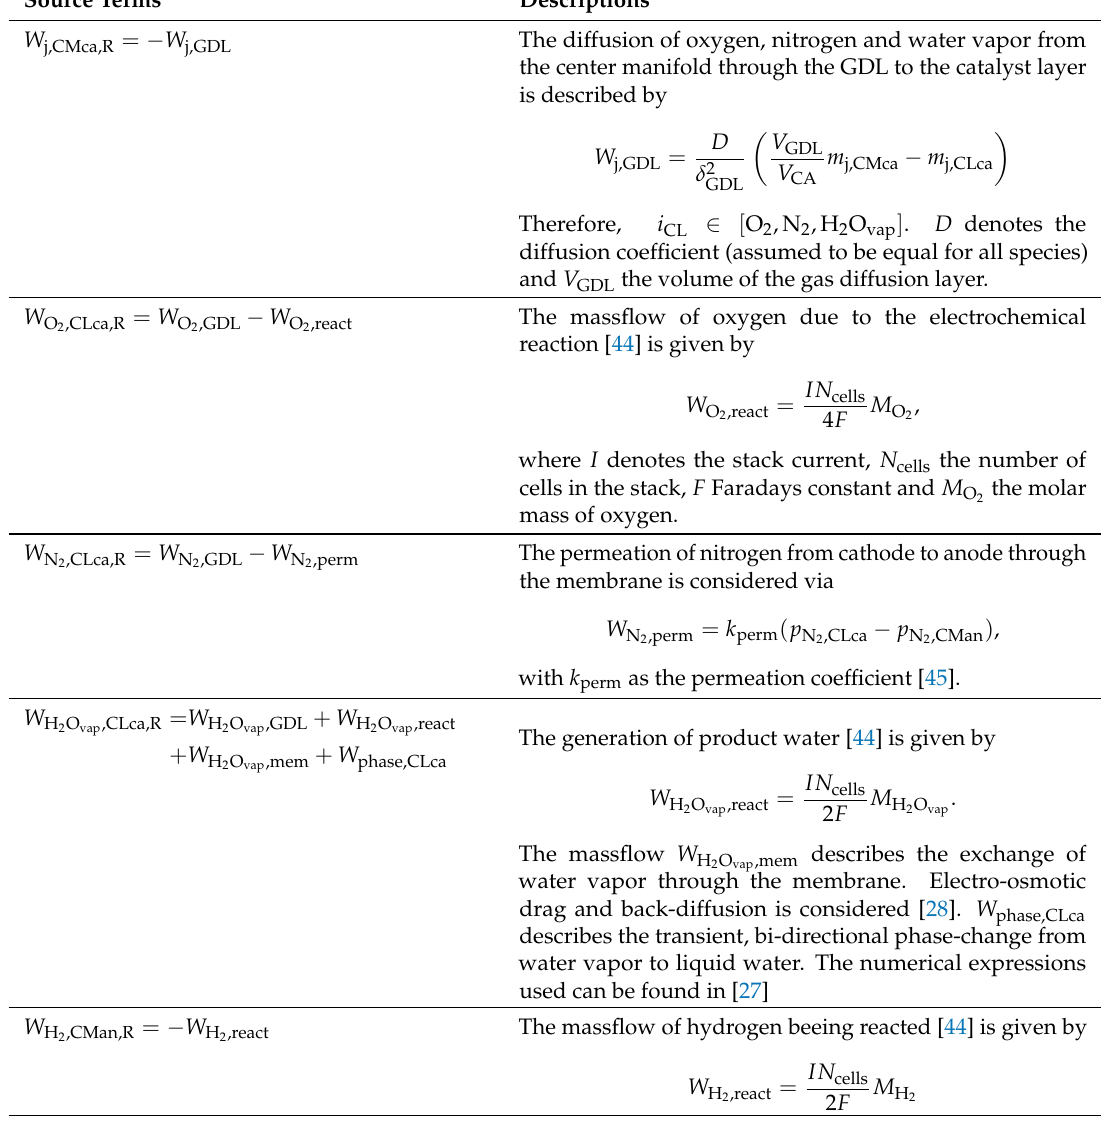
Table A1. Individual source terms for the lumped volumes of the fuel cell stack